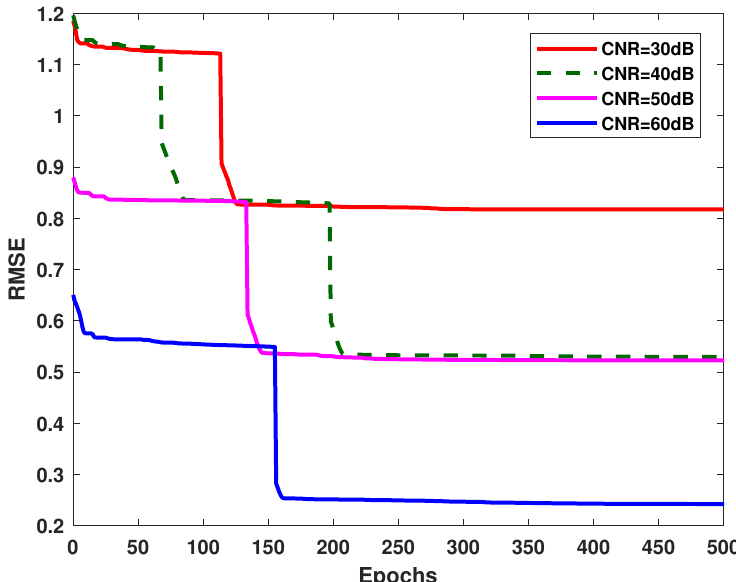
Figure 8. RMSE between the output and the original input versus the number of epochs.